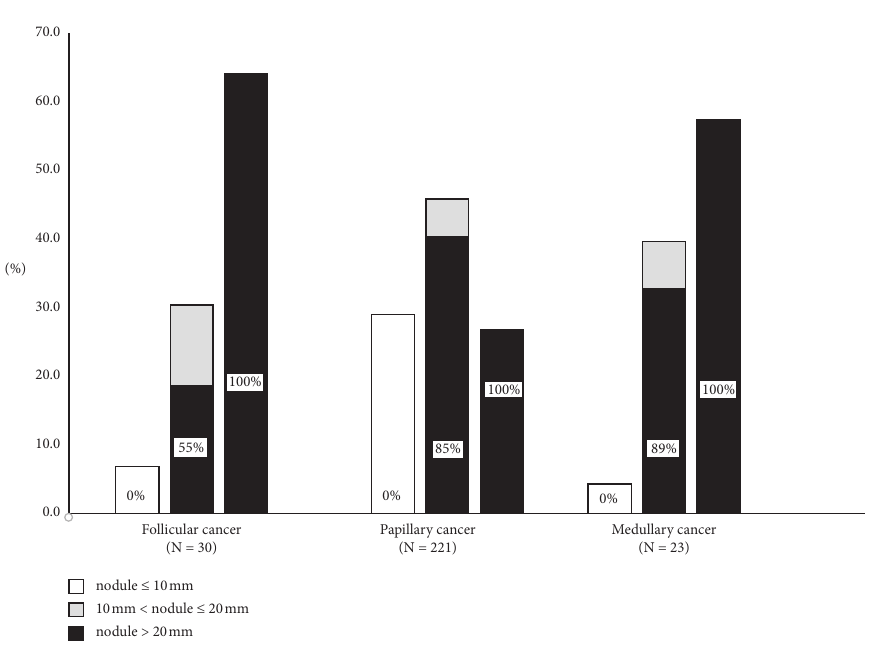
Figure 1: Indication of FNA based on EU-TIRADS. Size distribution of the three major thyroid cancer types; shaded areas show the proportion of the nodules in which the EU-TIRADS-based approach would have indicated FNA. The values in the bars are given in